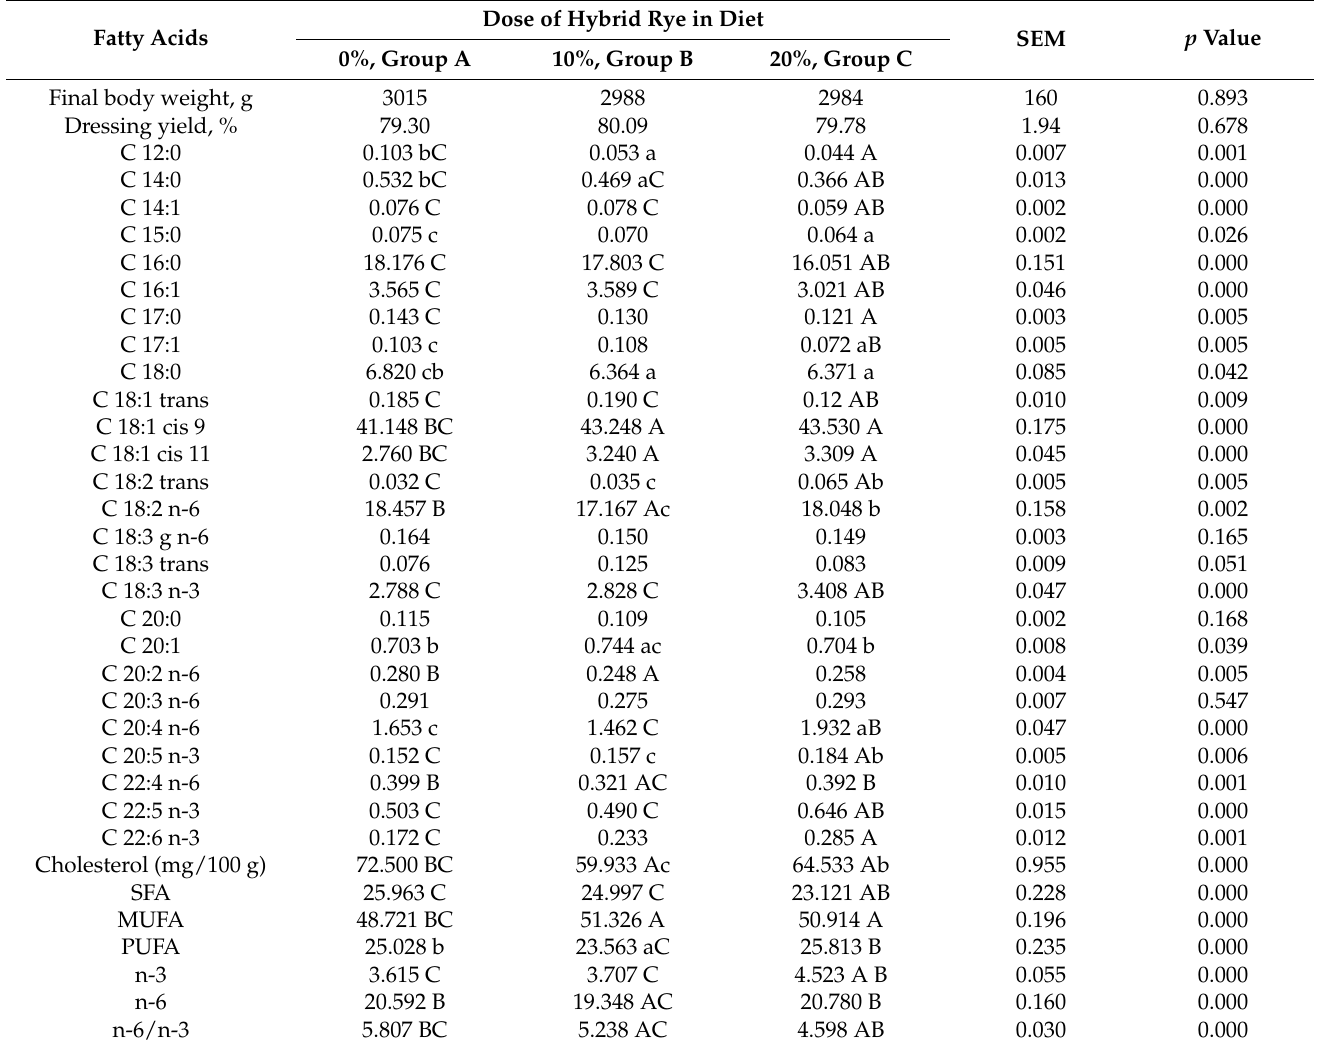
Table 6. Final body weight, dressing yield and fatty acids content in the breast muscles of chicken broilers fed with different doses of hybrid rye